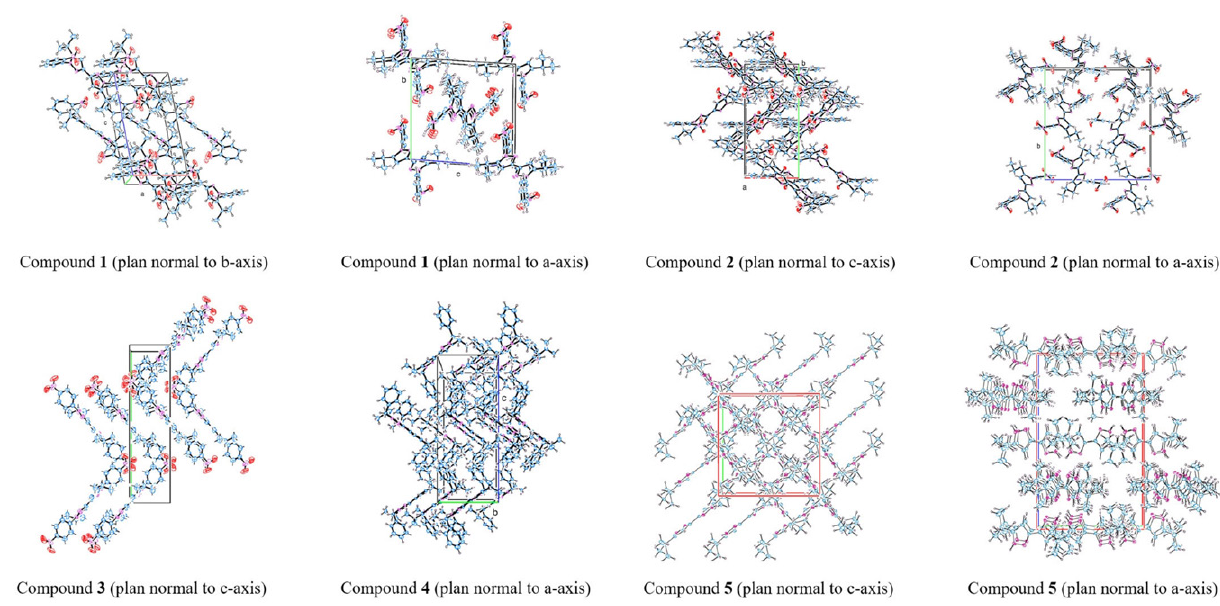
Fig. 4. Arrangement of molecules (projections) in the crystal structures for compounds